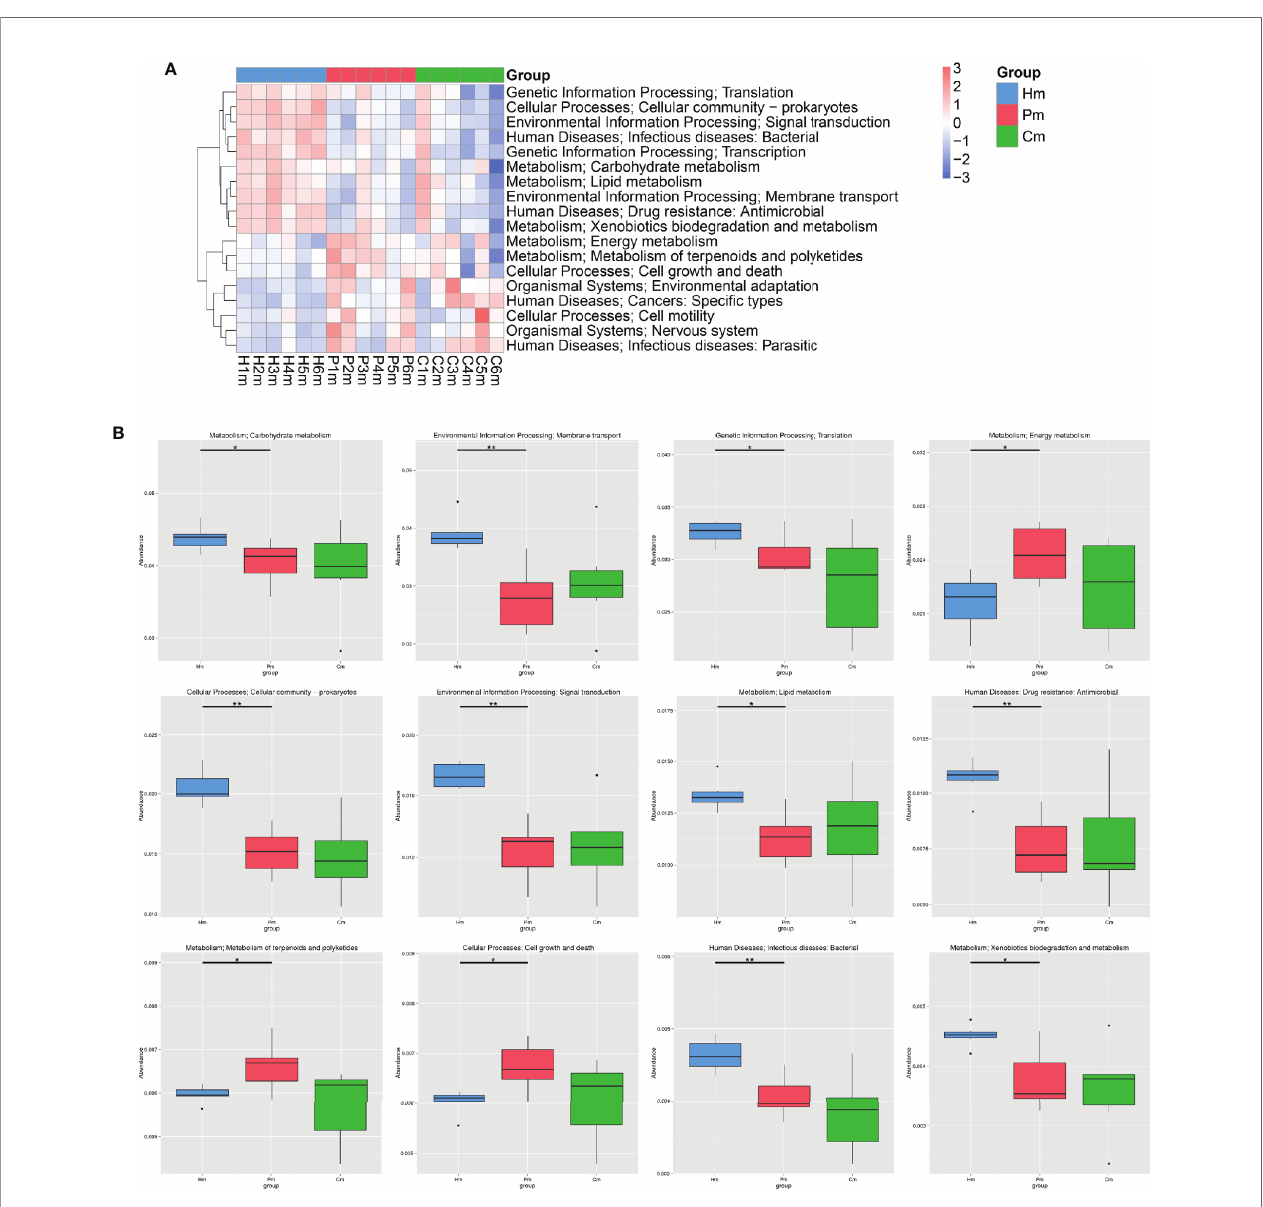
FIGURE 5 | KEGG level 2 pathway annotation according to the genetic data of the oral microbiomes from individuals in the Hm, Cm, and Pm groups. (A) Heatmap of the distribution of the top 18 KEGG pathways at the genus level. (B) Boxplots indicating the relative abundances of the top 12 KEGG pathways (* q -value < 0.05; ** q -value < 0.01; Metastats). Hm, healthy individuals; Pm, patients with periodontitis alone; Cm, patients with Crohn ’ s disease and